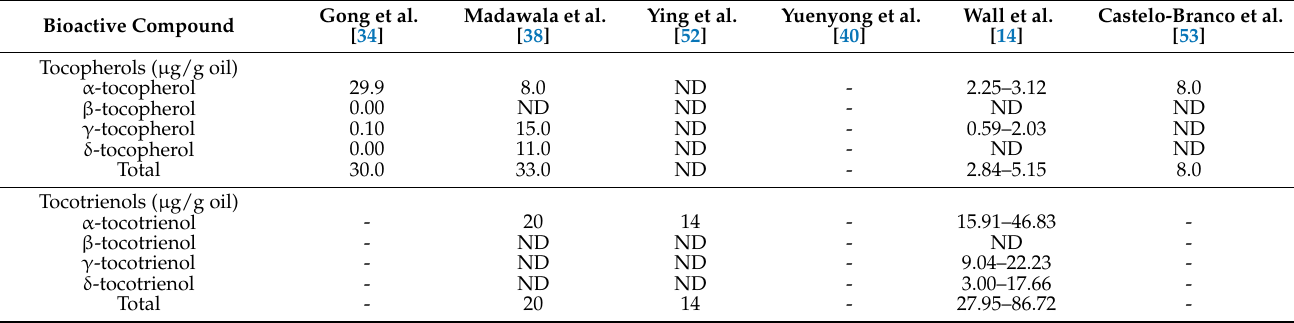
Table 4. Tocopherols, tocotrienols, and phytosterols content in cold-pressed macadamia nut